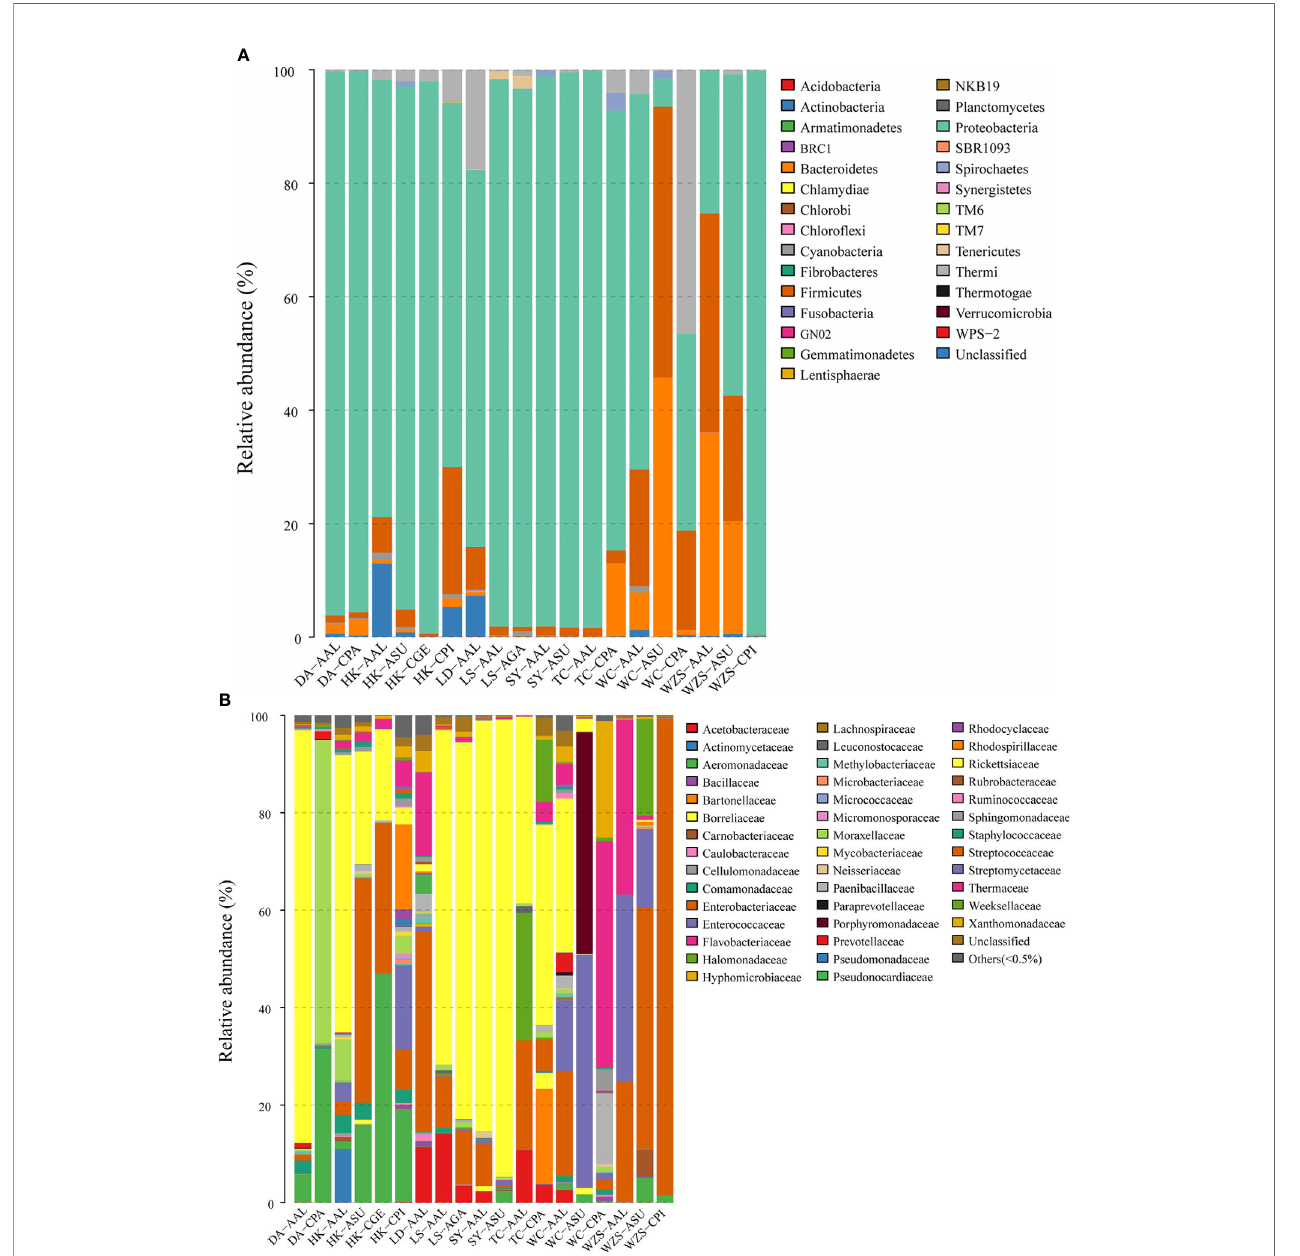
FIGURE 2 | Mean relative abundances of bacterial phyla (A) and families (B) associated with six mosquito species at different sites and collection dates. Families with abundance less than 0.5% were pooled together as “ Other. ” (DA, Dingan; HK, Haikou; LD, Ledong; LS, Lingshui; SY, Sanya; TC, Tunchang; WC, Wenchang; WZS, Wuzhishan; AAL, Aedes albopictus ; ASU, Armigeres subalbatus ; CGE, Culex gelidus ; AGA, Aedes galloisi ; CPA, Culex pallidothorax ; CPI, Culex pipiens